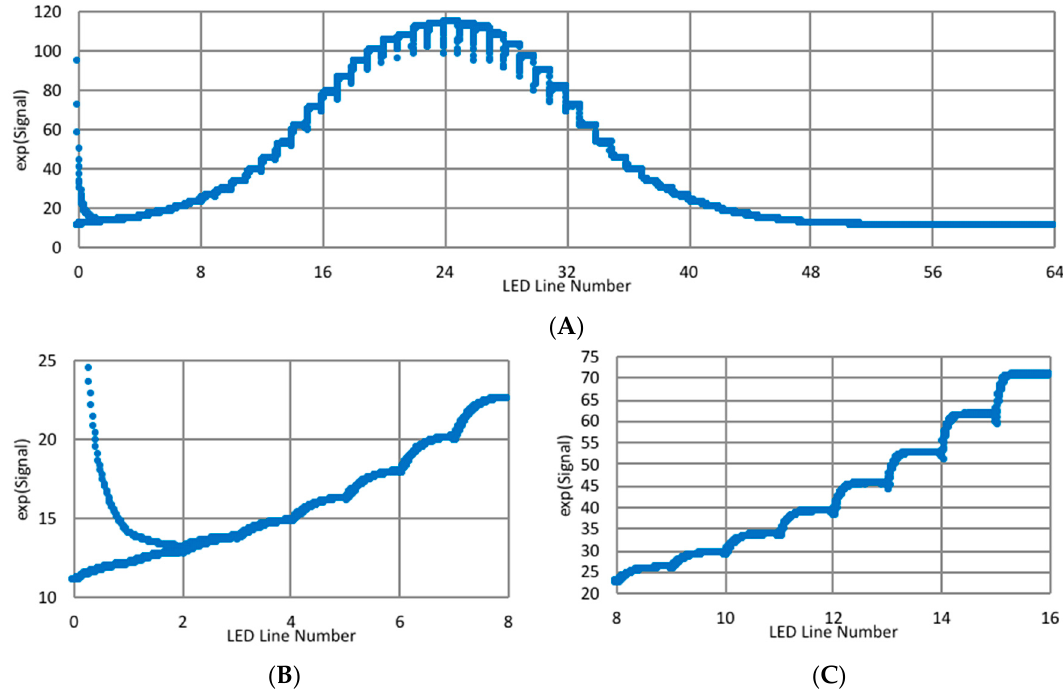
Figure 14. Sample signals (V) for LED lines from ( A ) one entire pass of pseudo-moving target, ( B ) LED lines 0–8, and ( C ) LED lines 8–16.